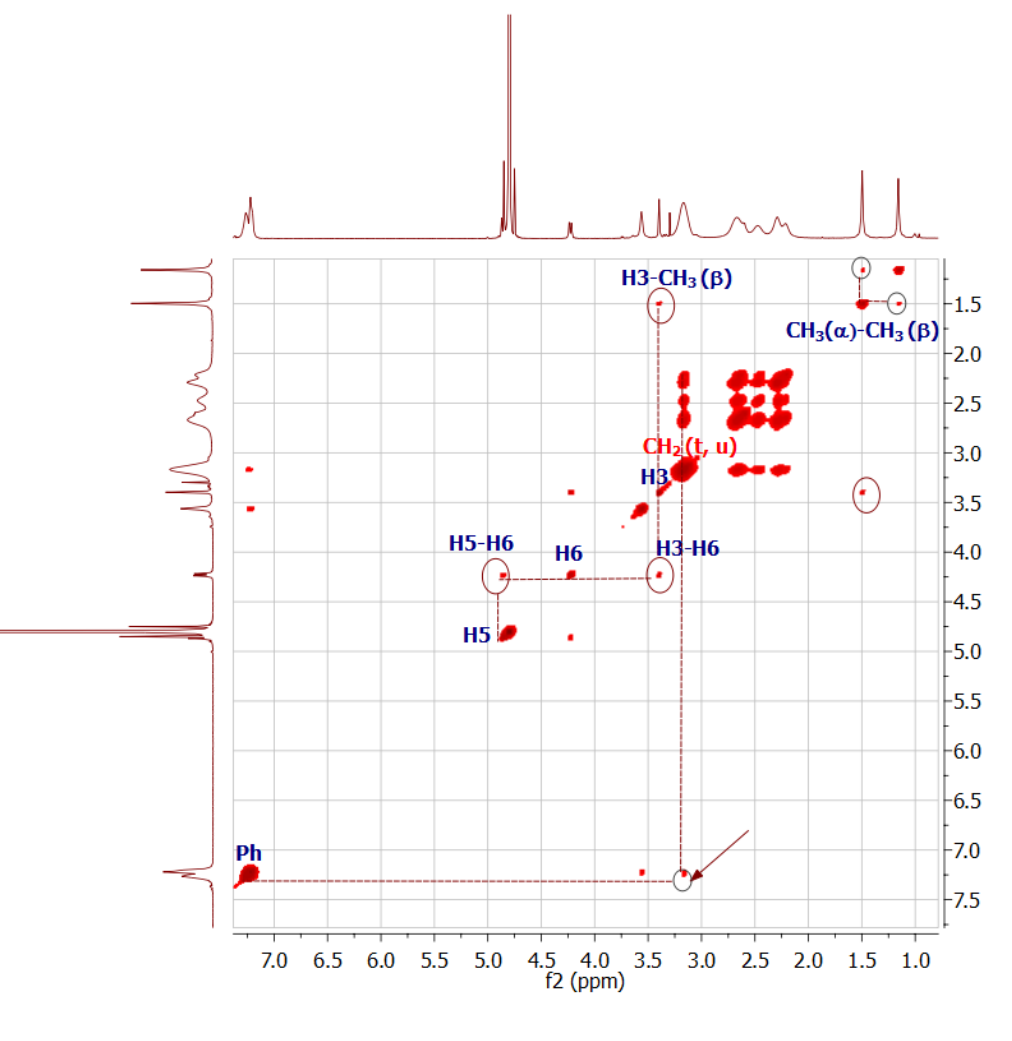
BPO . The arrow indicates cross-peaks between 4 64